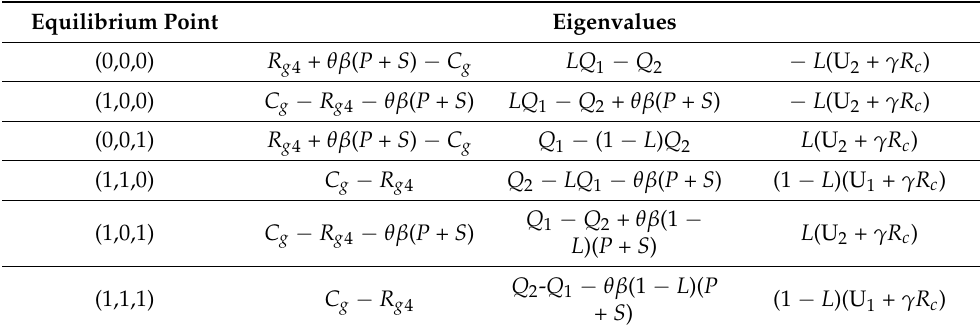
Table 8. Equilibrium point and eigenvalues of the Jacobian matrix corresponding to each equilib- rium